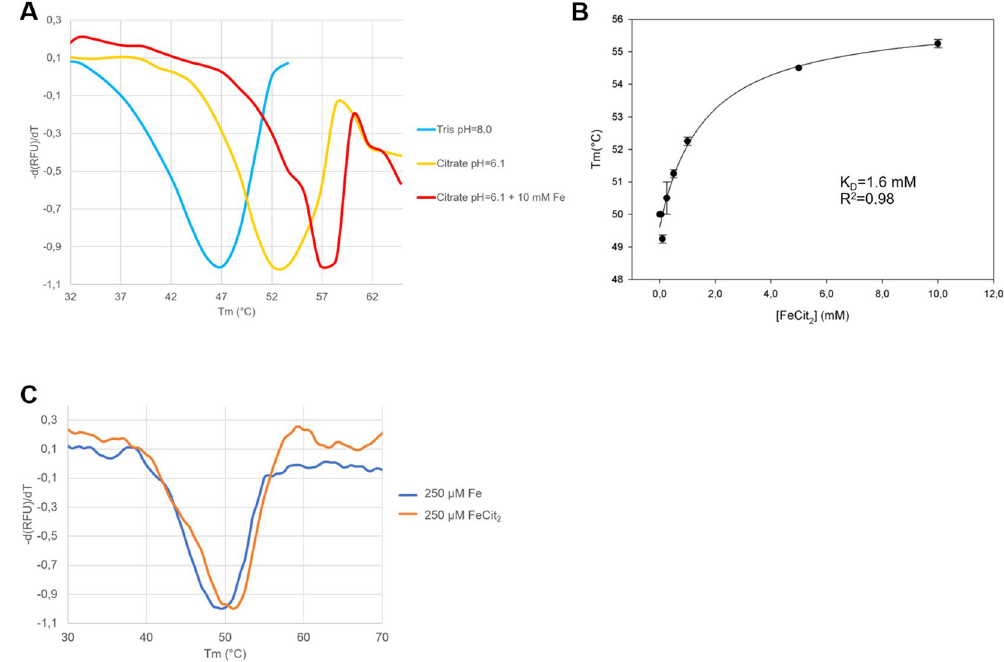
Figure 6. MtOPRT thermal shift experiments shown as derivative data. ( A ) Stabilizing effect of citrate buffer pH = 6,8 and 10 mM Fe(III) on MtOPRT Tm. ( B ) Affinity constant of MtOPRT toward FDC obtained by adding a stoichiometric 1:2 Fe(III)-citrate mix to the protein solution. ( C ) Stabilising effect of Fe(III) alone (blue curve) and of the 1:2 Fe(III)-citrate mix (orange curve) over MtOPRT Tm ( Δ Tm = 4,5